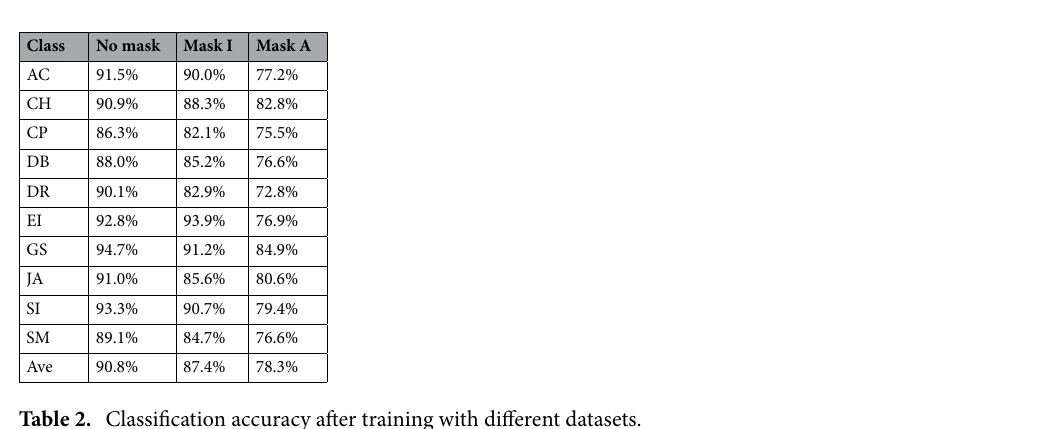
Table 2. Classification accuracy after training with different